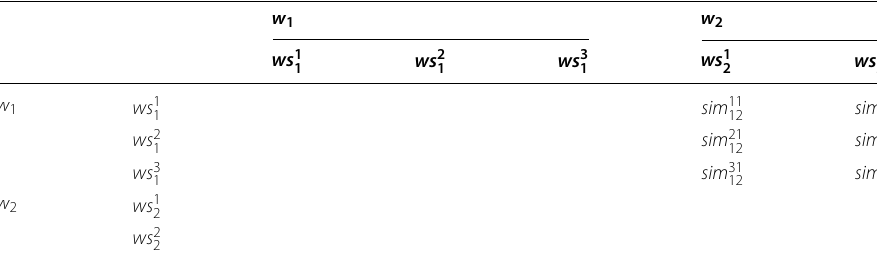
Table 3 Similarity between word senses